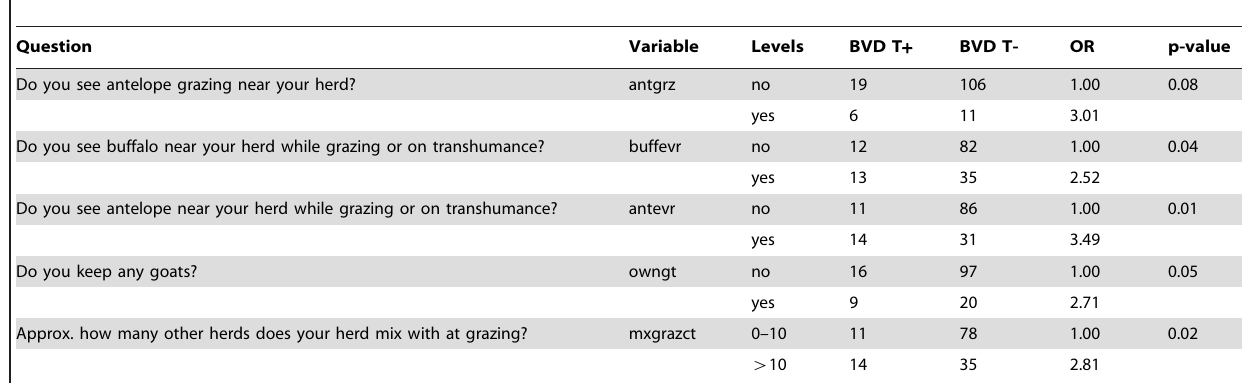
Table 1. Univariable analysis of potential risk factors for having a persistently infected presumed bovine viral diarrhoea virus (PI) calf in the herd in the Adamawa Region of